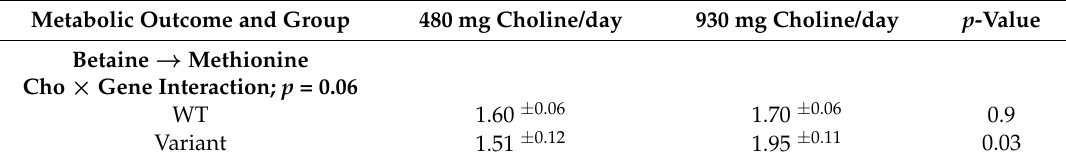
Table 15. SLC44A1 rs7873987 genotype alters the metabolic flux of betaine → DMG. Values are least-squared means ± standard errors in µM DMG/study period. p -values represent the highest order interaction and pairwise comparisons between genotypes within intake groups.